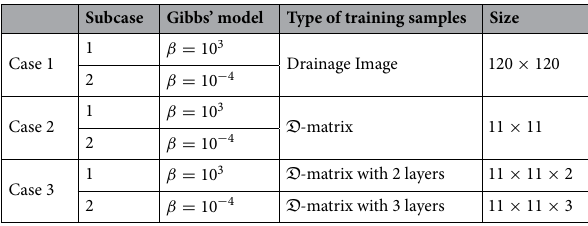
Table 2. Training samples used in each case: (Case 1) the drainage network images from Gibbs’ model, (Case 2) their corresponding D -matrix, and (Case 3) connectivity-informed D -matrices.